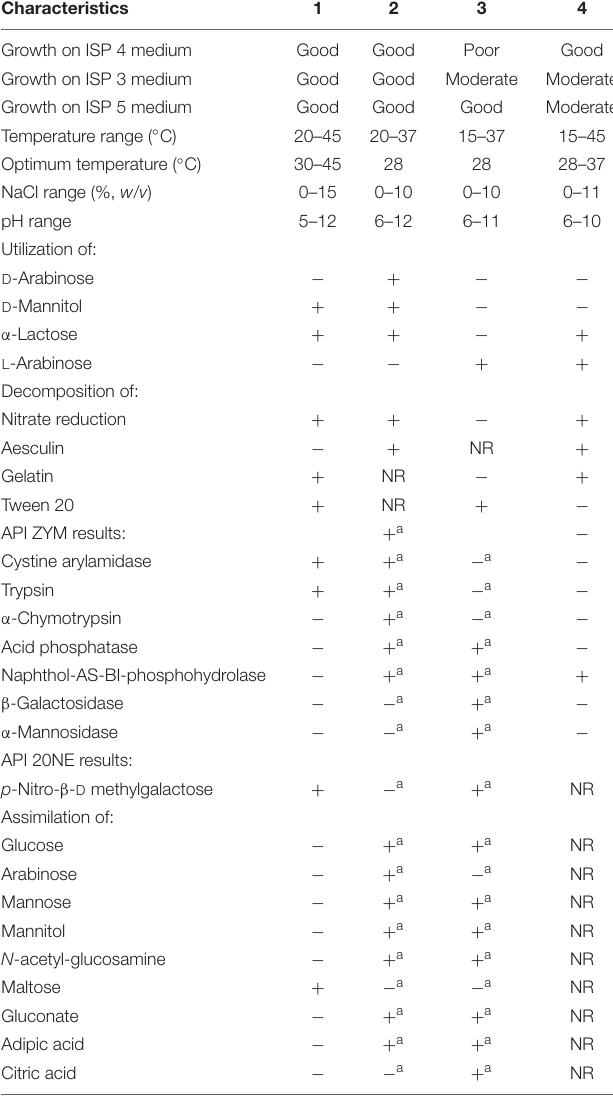
TABLE 1 | Differentiation of the physiological characteristics of strain YIM 96748 T , Amycolatopsis cihanbeyliensis BNT52 T , Amycolatopsis jiangsuensis KLBMP 1262 T , and Amycolatopsis suaedae 8-3EHSu T